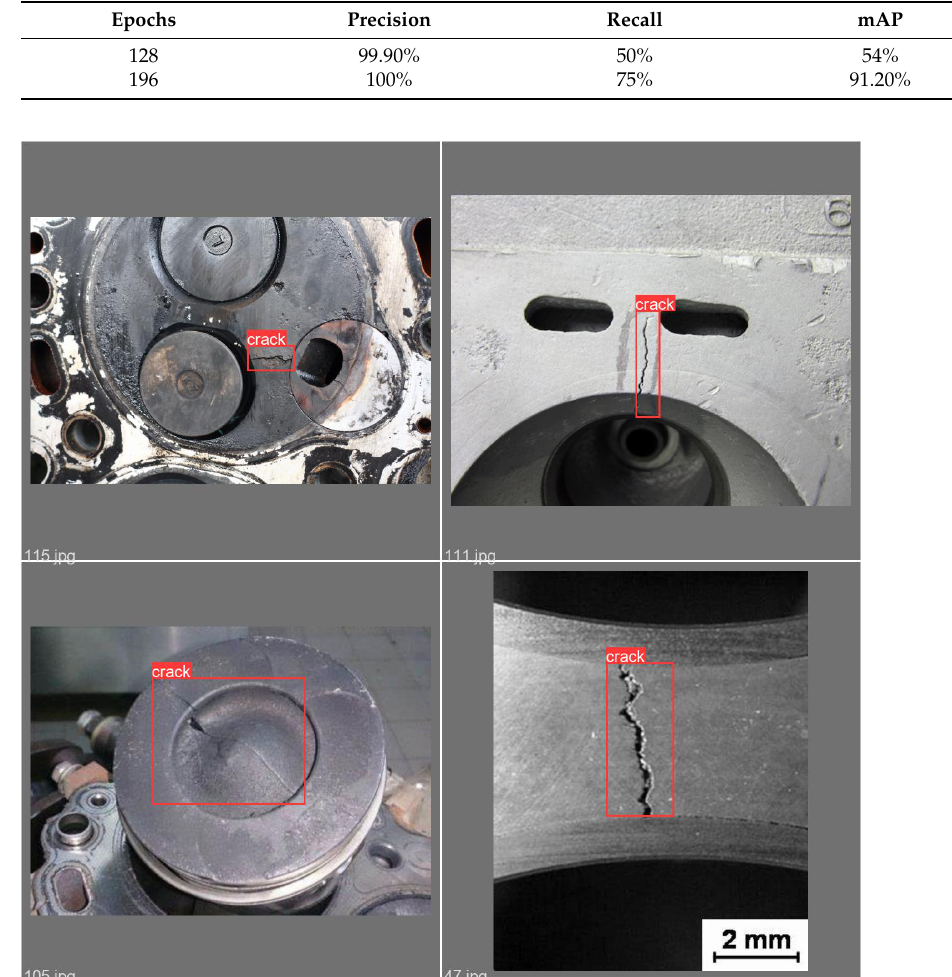
Table 9. Detection results obtained using the modified YOLOv5s architecture.